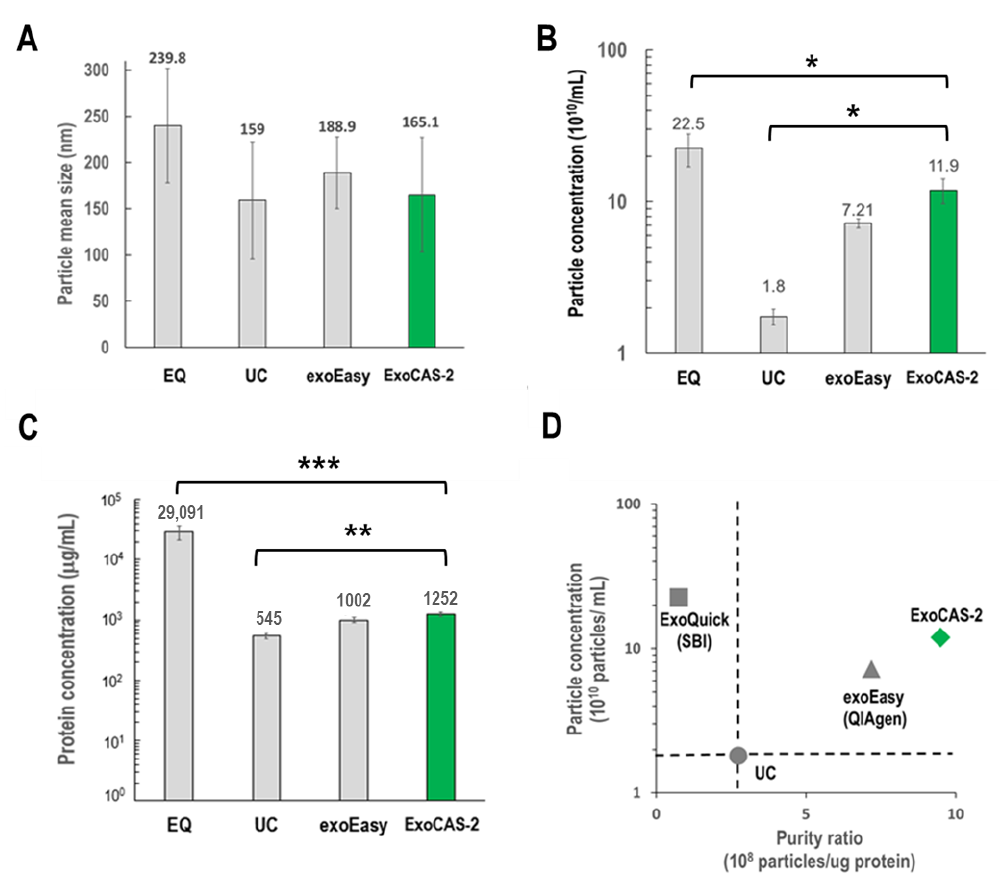
Figure 3. Comparison of EV isolation methods (EQ, UC, exoEasy, PLL-beads) using NTA, and BCA. ( A ) Mean size. ( B , C ) Particle concentration and protein concentration (*: p < 0.05, **: p < 0.01, ***: p < 0.001). ( D ) Normalized purity ratio (particle/protein ratio), using UC as a reference standard for both particle and purity ratio (dotted line). EQ: ExoQuick (SBI), UC: ultracentrifugation,exoEasy (Qiagen), ExoCAS-2: present research.